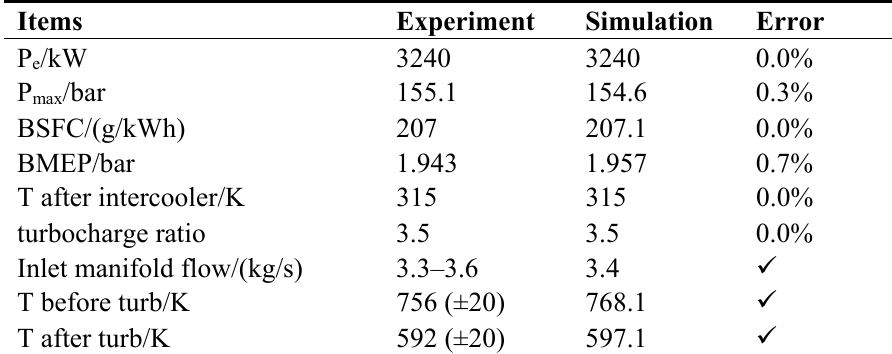
Table 3. Comparison of the performance parameters between experimental and simulative data under rated conditions.